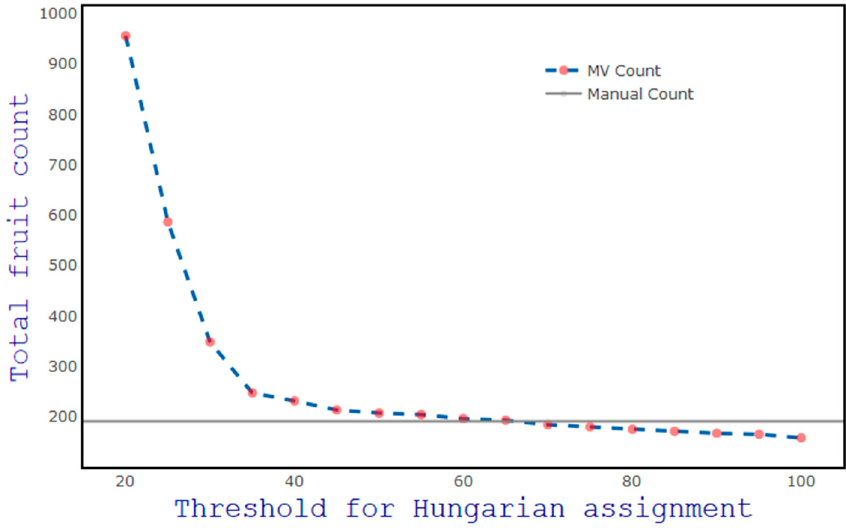
Figure 9. Impact of the value of threshold for Hungarian assignment on fruit count in the video. The horizontal line denotes the human count of fruit in frame.